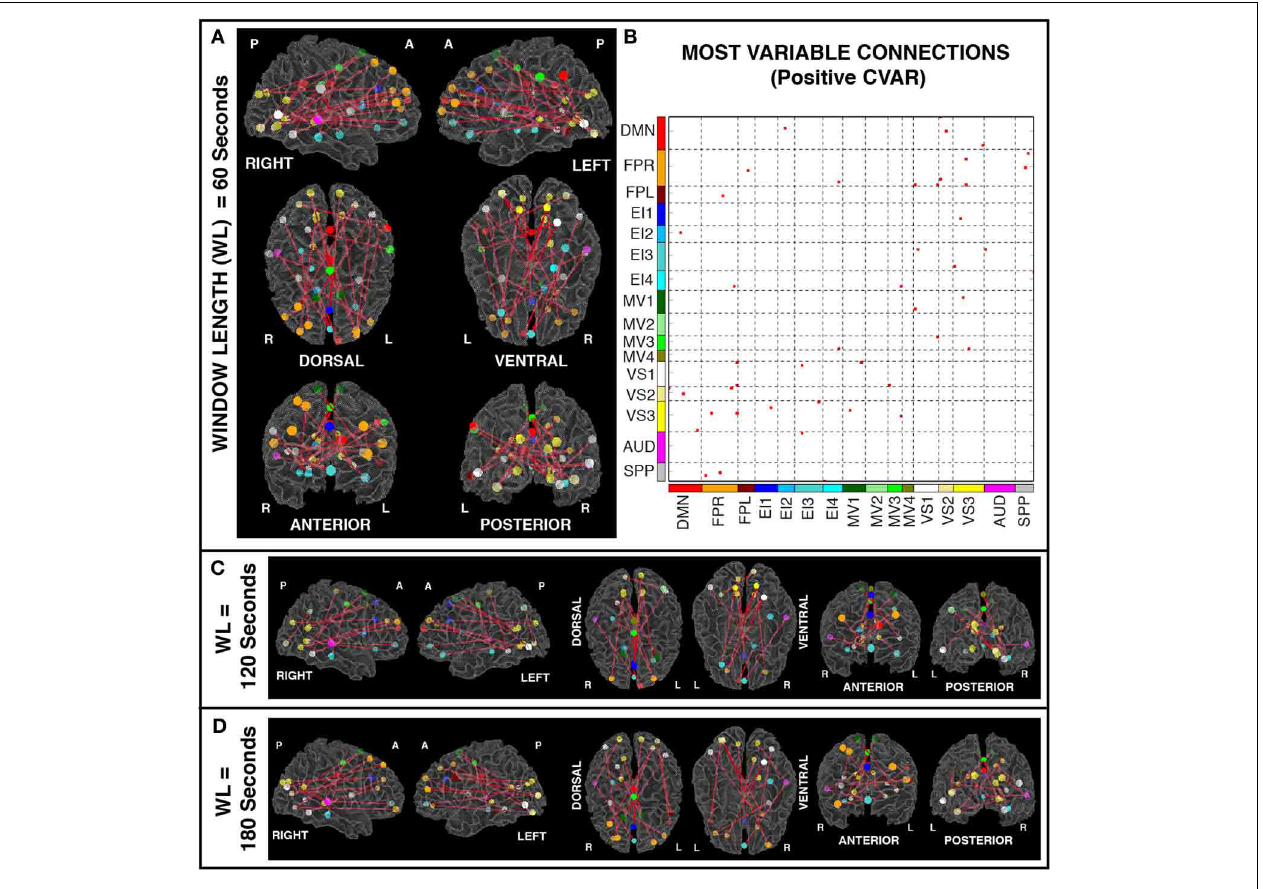
FIGURE 6 | (A) Most variable positive connections for window length = 60s. Connections classified as most variable in all 11 participants are shown over 3D renderings of a brain surface. (B) The same information shown as a 2D matrix. Colors corresponding